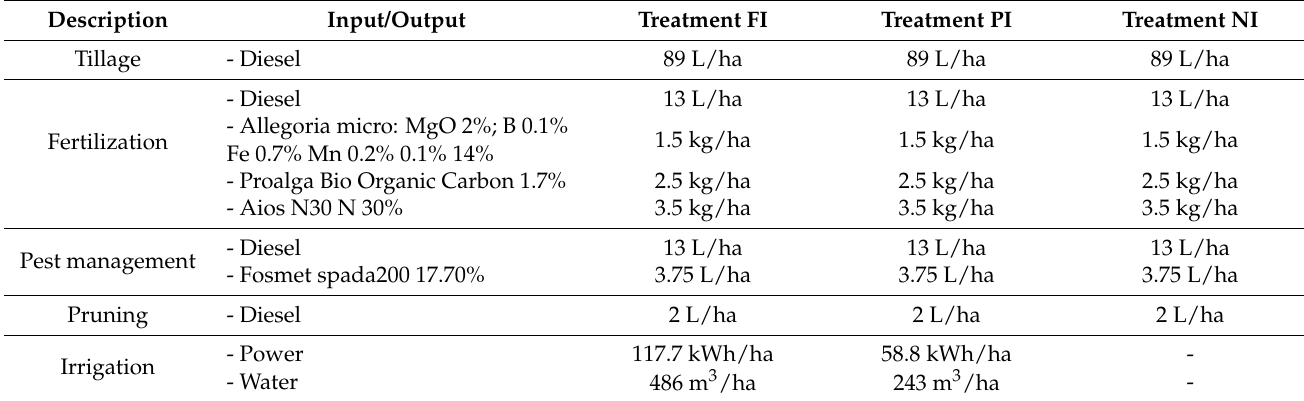
Table 3. Inventory of the LCA in the three